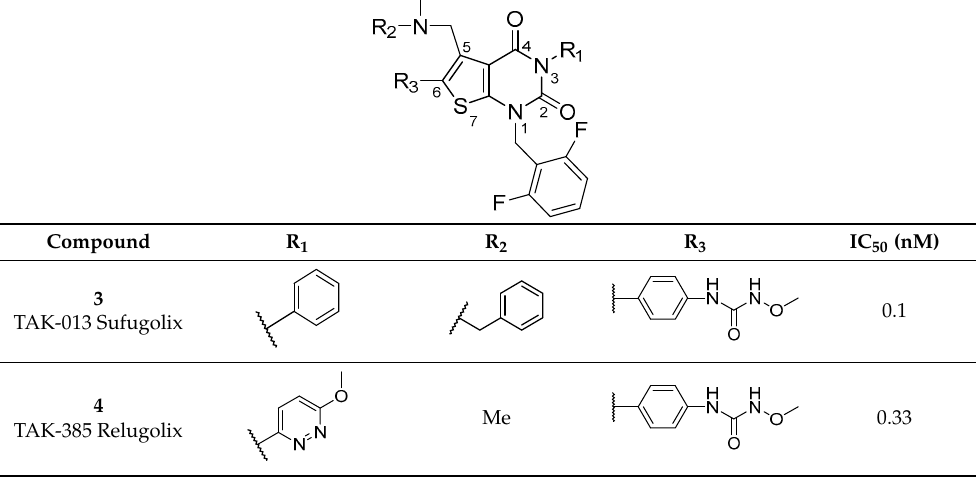
Table 1. Thieno[2,3- b ]pyridine-4-one derivatives and their binding affinities at human GnRH-R .